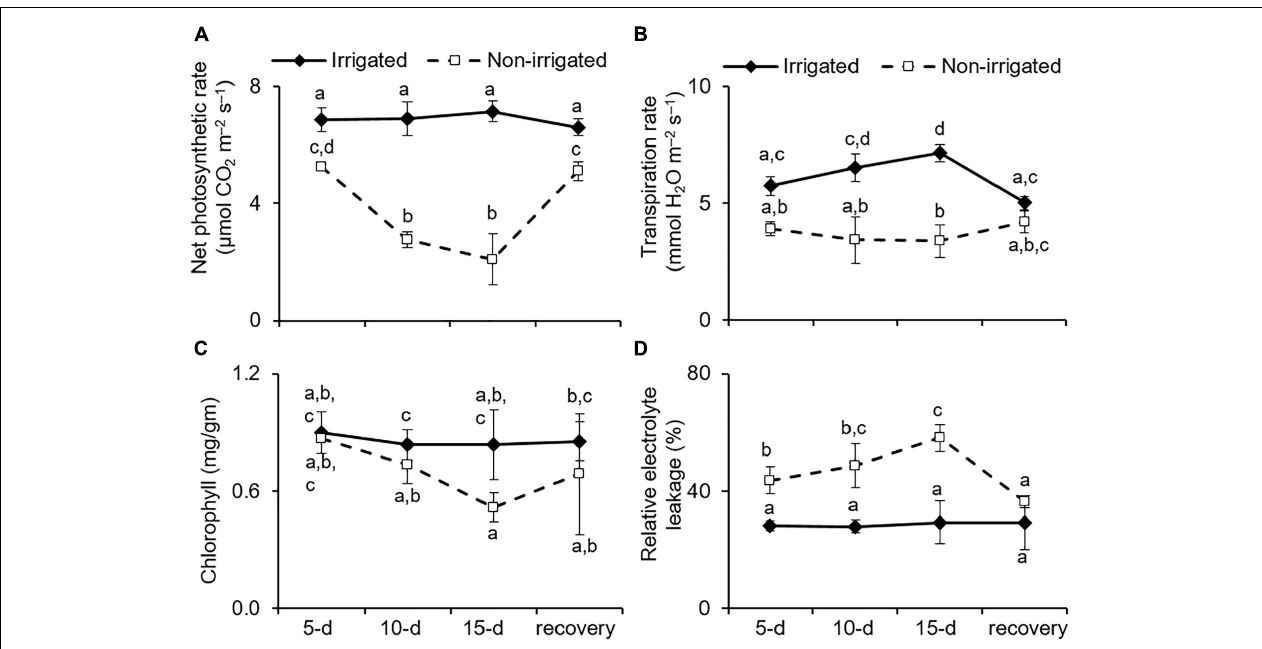
FIGURE 4 | Water deficit negatively impacted the physiology of S. hexandrum . (A) Net photosynthetic rate. (B) Transpiration rate. (C) Chlorophyll content. (D) Relative electrolyte leakage showing membrane damage. The data values show mean ± SE of three independent biological replicates. Lowercase letters represent statistical significance of differences between the mean values ( P < 0.05, Duncan’s multiple comparison test).